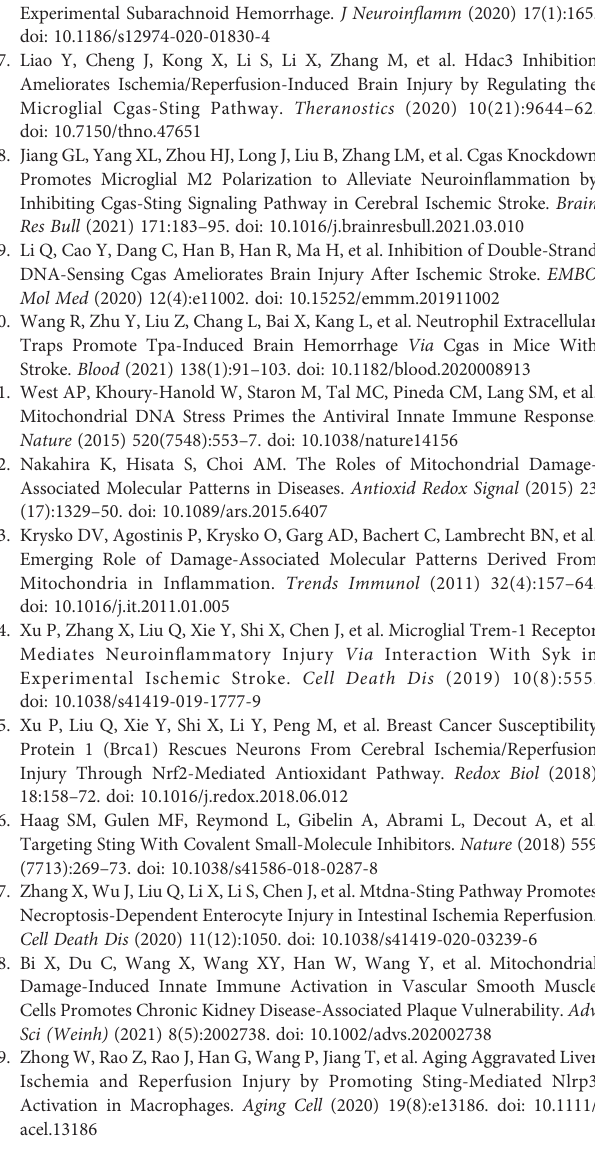
Supplementary Table 1 | Animalusageandmortalityofalltheexperimentalgroups. Supplementary Table 2 | Antibodies used in this study. Supplementary Table 3 | Sequences of the PCR primers used in the